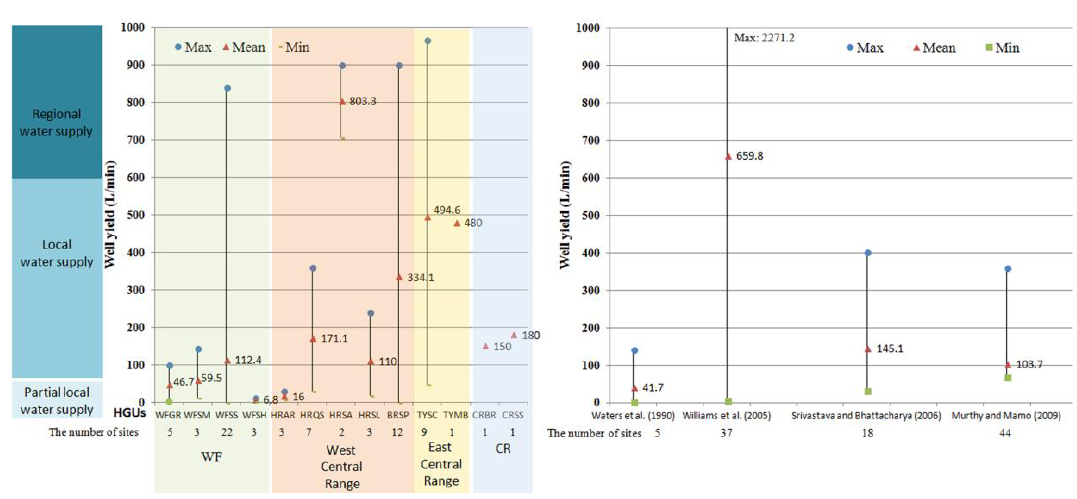
Figure 6. Distributions of well yields in this study and literature.